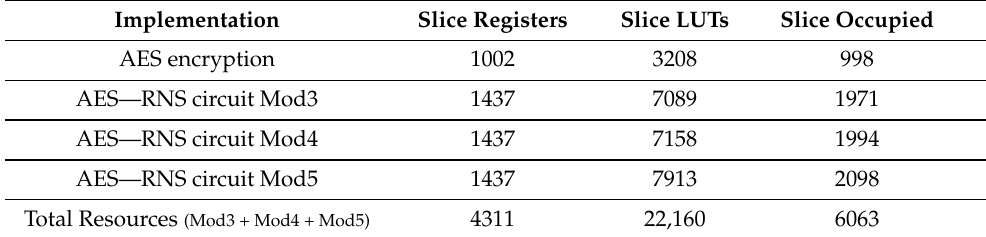
Table 8. Hardware resource utilization of AES.